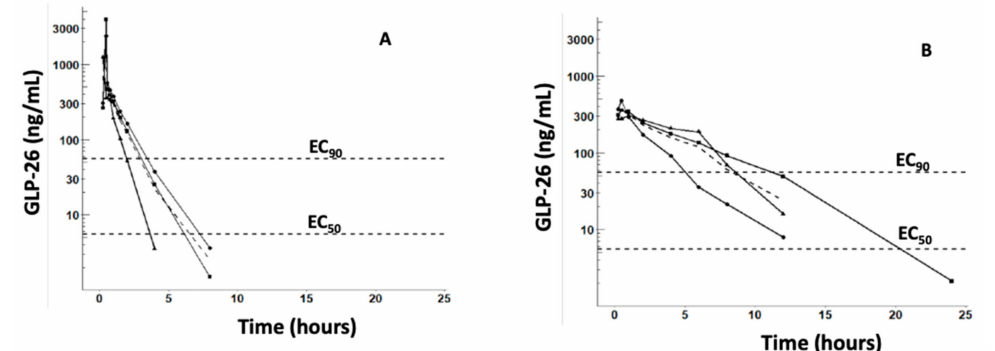
Figure 5. Plasma concentration versus time profiles of GLP-26 in cynomolgus monkeys adminis- tered 1 mg/kg IV ( A ) or 5 mg/kg PO ( B ). Solid curves and markers represent concentrations of GLP-26 in individual monkeys, while dashed curves represent means. Only concentrations >limit of quantification (1 ng/mL), are plotted. Also plotted are the in vitro EC 50 (3 nM~1.1 ng/mL) and EC 90 (30 nM~11 ng/mL) versus HBV, corrected 86.7% binding in monkey plasma and 17.9% binding in vitro (2% FBS),